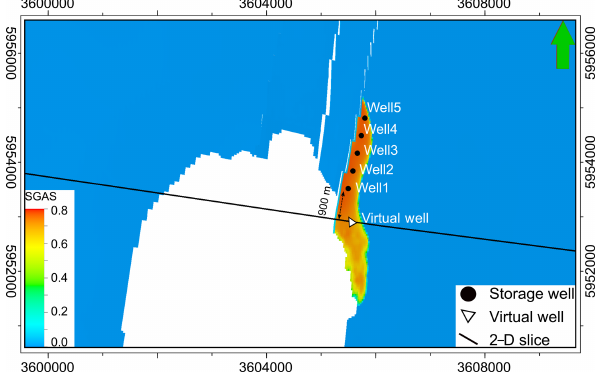
Figure 2. Gas phase distribution in the 3-D model after the stor- age initialisation. Five vertical storage wells located near the top of the anticline, 900m from well 1 is the “virtual” well for pressure controlling in 2-D study.